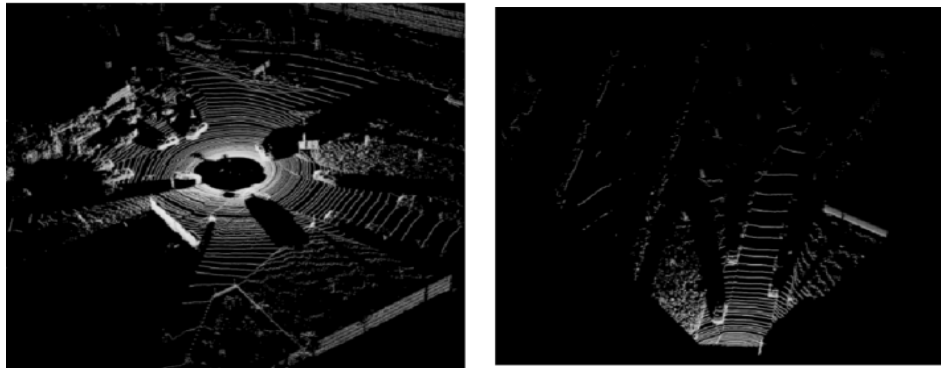
Figure 3. Comparison of point cloud data before and after preprocessing.